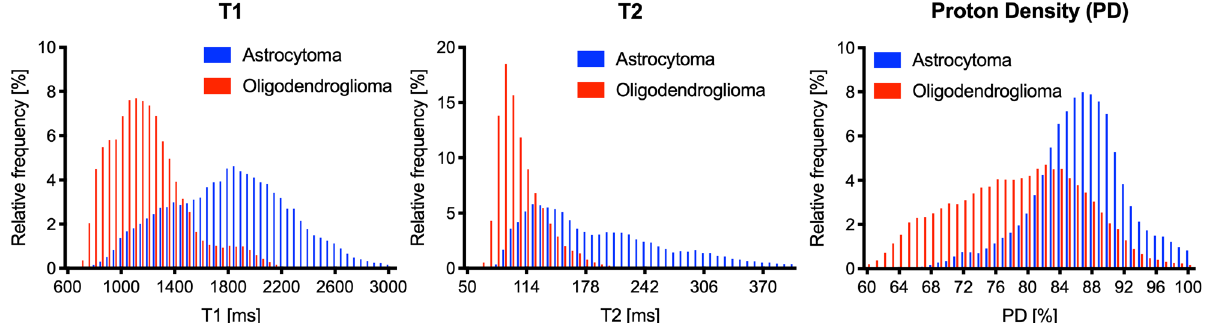
Figure 2. Histograms of T1 and T2 relaxation times and proton density (PD) between IDH-mutant astrocytomas and IDH-mutant and 1p/19q-codeleted oligodendrogliomas. All parameters (T1 and T2 relaxation times and PD) in astrocytomas exhibit a slight rightward shift (‘+’) relative to those in